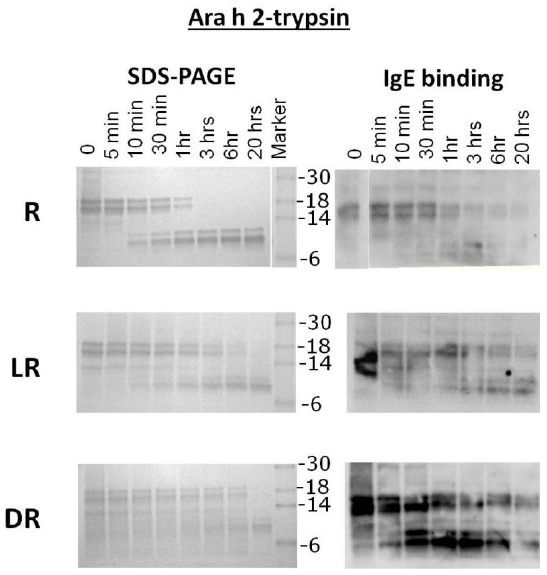
Figure 4. SDS-PAGE analysis and IgE western analysis of the digestion of raw, light roast (LR) and dark roast (DR) Ara h 2 with trypsin. Raw Ara h 2 (R), light roast Ara h 2 (LR) and dark roast Ara h 2 (DR) were digested by trypsin for the designated amounts of time of 5 min (5’) to overnight (O/N). Other lanes are labeled Ara h 1 and Ara h 2 control (C), undigested (U) and molecular weight marker. The molecular weights of the marker proteins are indicated on the